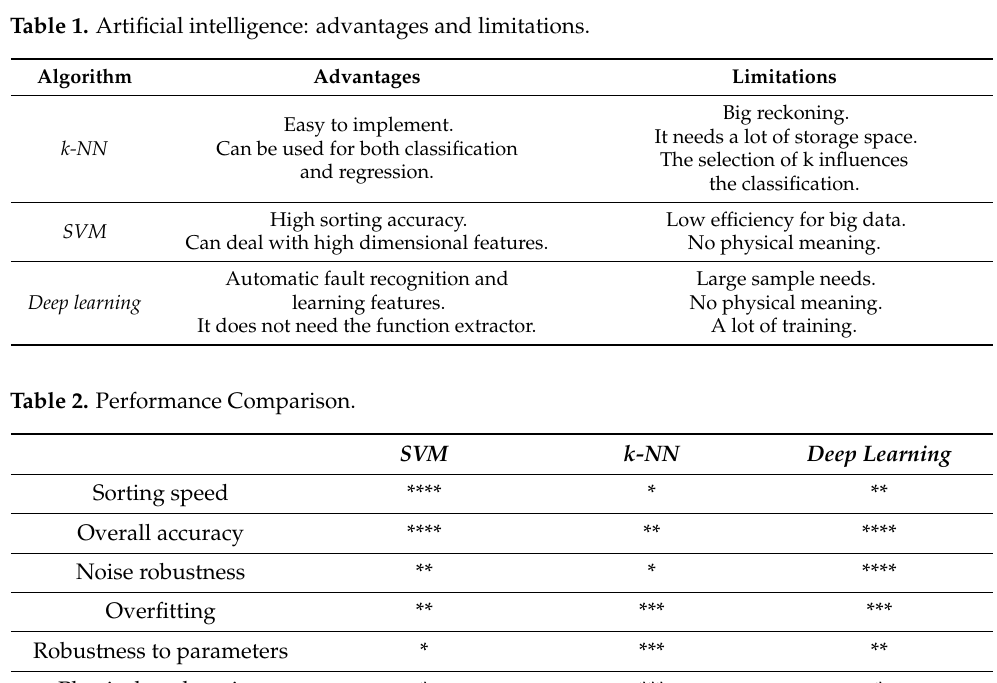
Figure 2. An autoencoder is represented graphically. A function ℎ (cid:3024),(cid:3029) ≈ 𝑥 is learned by the autoencoder, W is the parameter (or weight), and b is the bias associated with the connection between two layers. A low-dimensional representation of the original data can be learned since the autoencoder can detect corre- lations between the data if there are any. A stacked autoencoder is composed of multiple layers of sparse autoencoders, whose outputs are interconnected. In addition to fault diagnosis, DBN is also a useful tool, which is a series of multiple layers of restricted Boltzmann machines (RBMs); this is a particular type of log-linear Mar- kov Random Field (MRF) called a Boltzmann machine (BM). As a result, its free parame- ters are linear. Several hidden variables are considered to make it powerful enough to